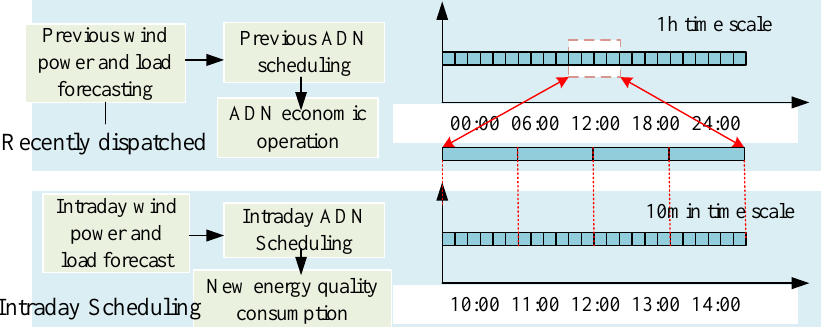
Figure 5. Multi-timescale optimization schematic.